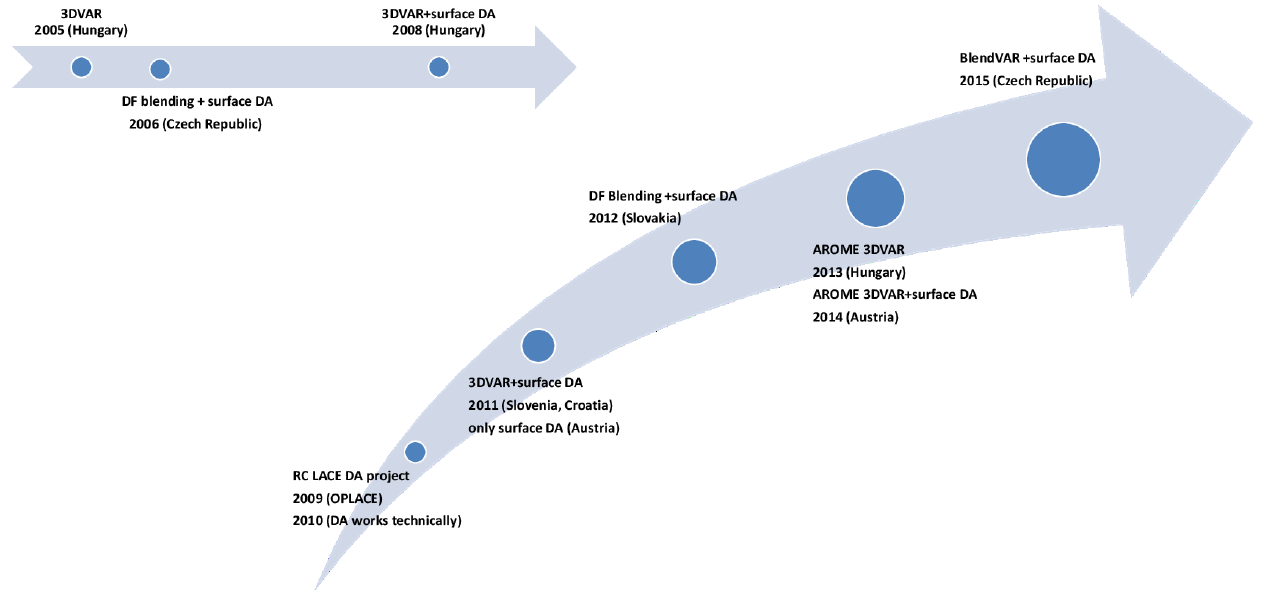
Figure 1. Milestones of operational data assimilation (DA) implementation in RC LACE